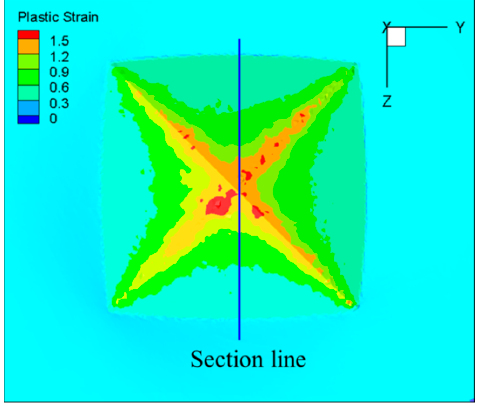
Figure 15. Strain contour of indentation (Temperature = 20 °C, Load = 10 kg).